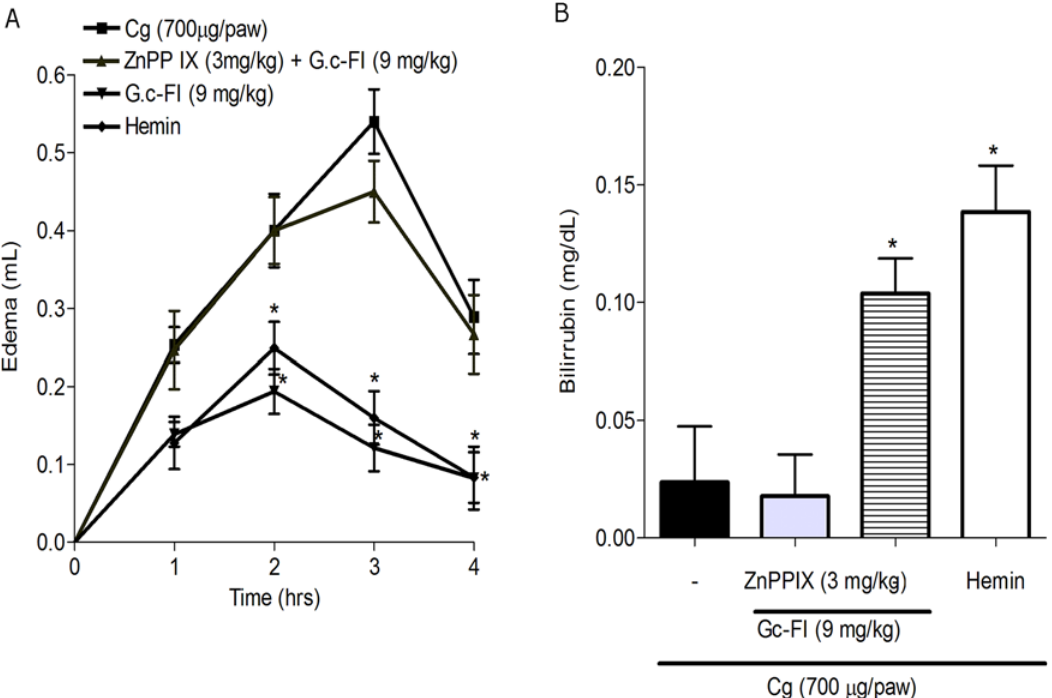
Fig 8. HO-1 activity in paw edema induced by Cg (A) and bilirubin levels (mg/dl) in the blood plasma of rats after pretreatment with ZnPP IX (B). Data are expressed as the mean ± S.E.M of six rats for each group. * p < 0.05 from the Cg group (ANOVA, Bonferroni ’ s test).